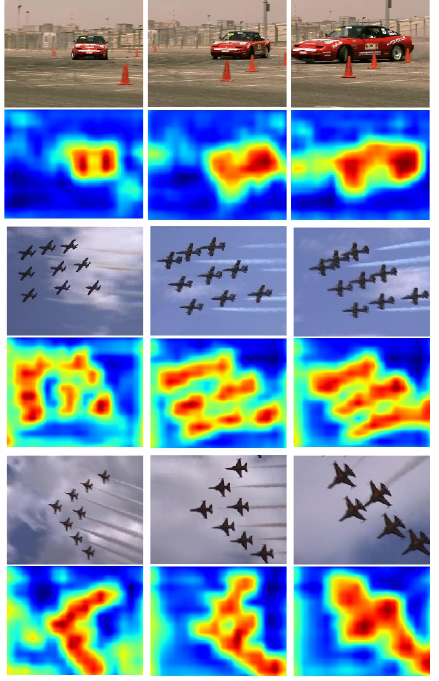
Figure 6. Illustration of local attention.